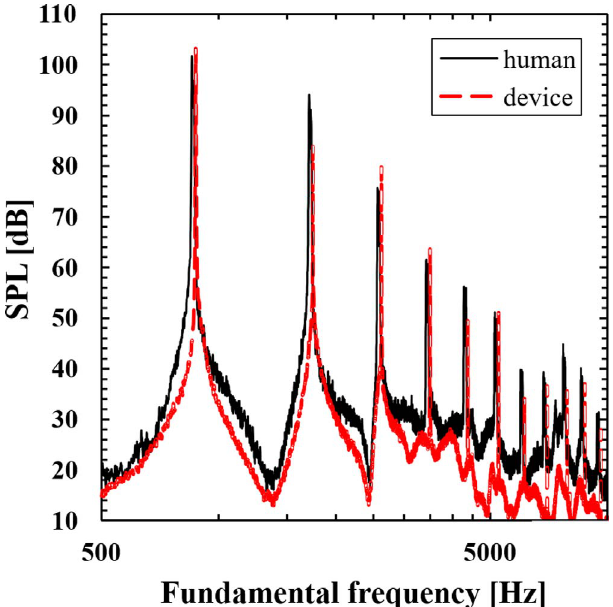
Figure 8. Sound pressure spectra of radiated sound produced by human player and arti fi cial blowing device, where blowing parameters for the device were set to the values in Table 1.